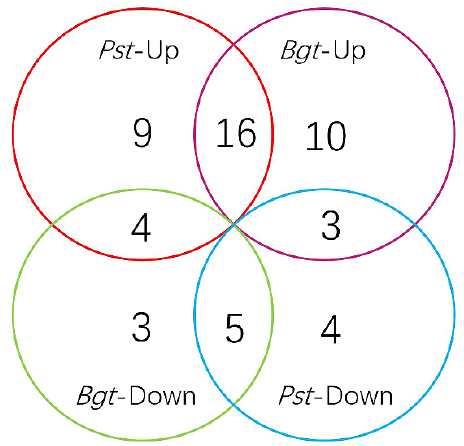
Figure 1. Distribution of di ff erentially expressed (DE) Triticum aestivum NAC (TaNAC) unigenes under stress from stripe rust and powdery